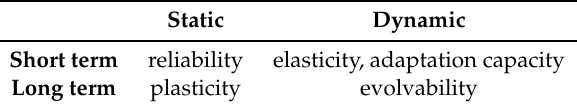
Table 1. The five characteristics of